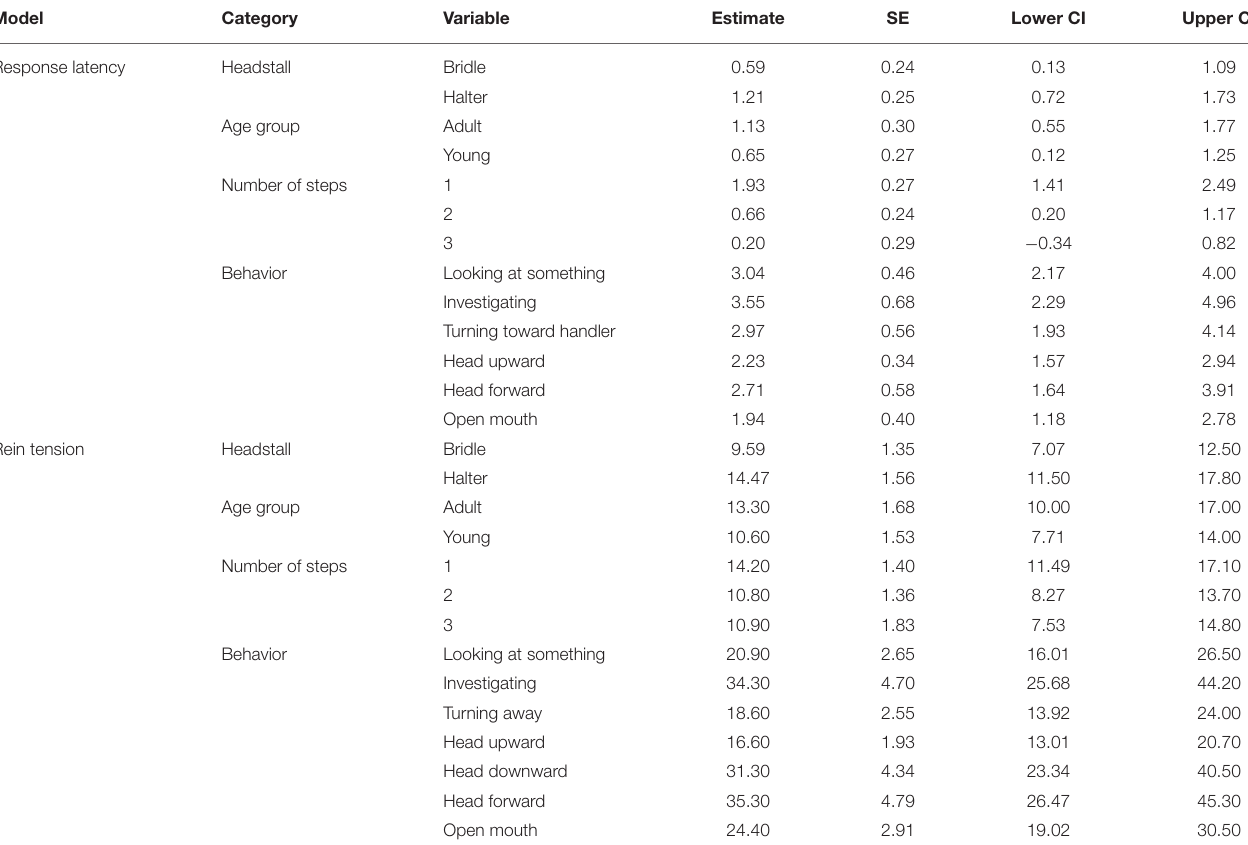
TABLE 4 | Back-transformed least square means from the response latency model (s) and the rein tension model (N) for headstall, age group, and number of steps when controlling for behavior, and presence/absence for behavior.